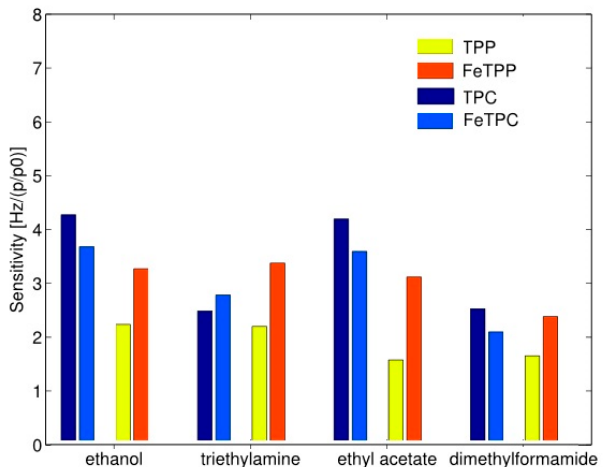
Figure 11. Sensitivity of free-base porphyrin (TPP) and porphyrin with iron (FeTPP) in comparison to analog porphyrin (TPC) and analog porphyrin with iron (FeTPC). Units of Hz per relative concentration ( p / p 0 ). Partially reprinted with permission [34].